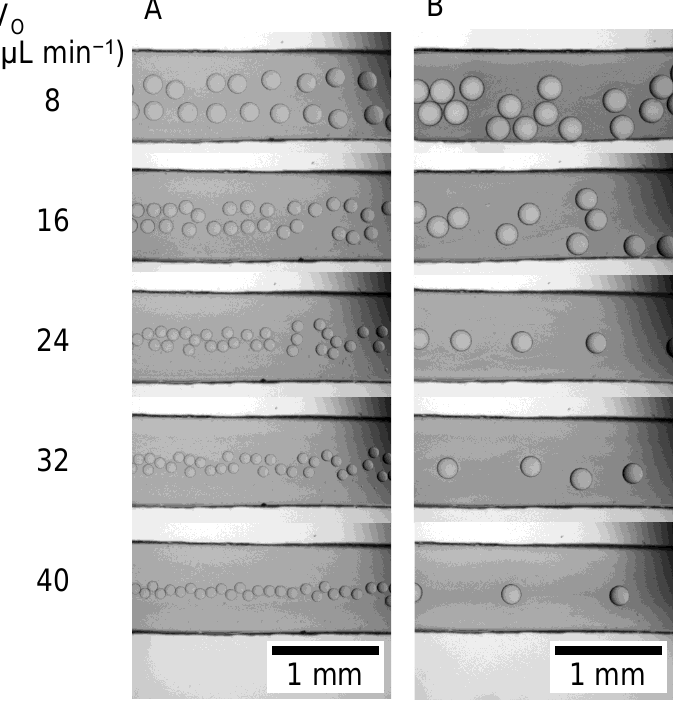
Figure 4. Microscopic images microdroplets observed in a T-shaped microchannel. V O denotes the volume flow rate of continuous phase. The volume flow rate of the dispersed phase was fixed to 1 μL min −1 . Dispersed phase: ( A ) PBS, ( B ) 10% PEG solution. Continuous phase: Oil for droplet digital PCR.